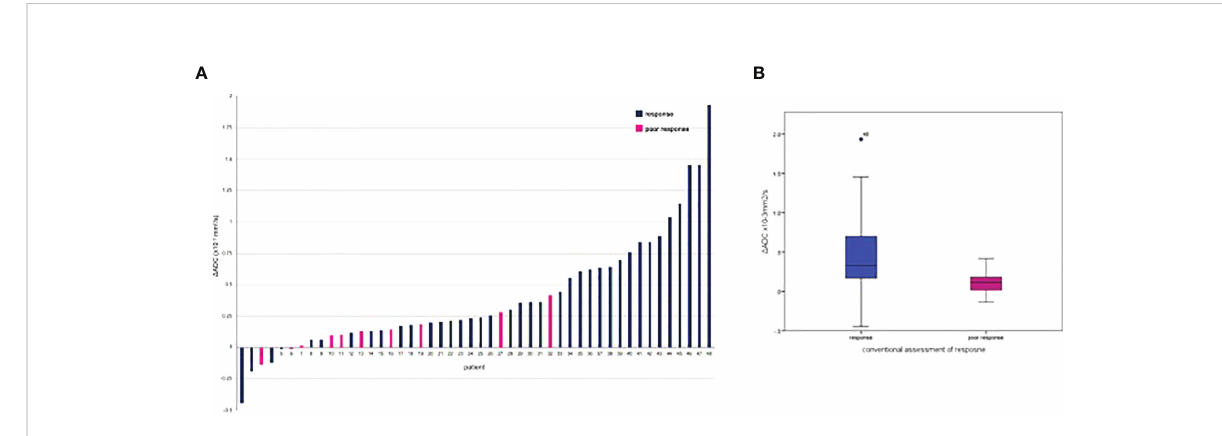
FIGURE 2 D ADC all mean following neo-adjuvant chemotherapy grouped by conventional response: (A) per patient water